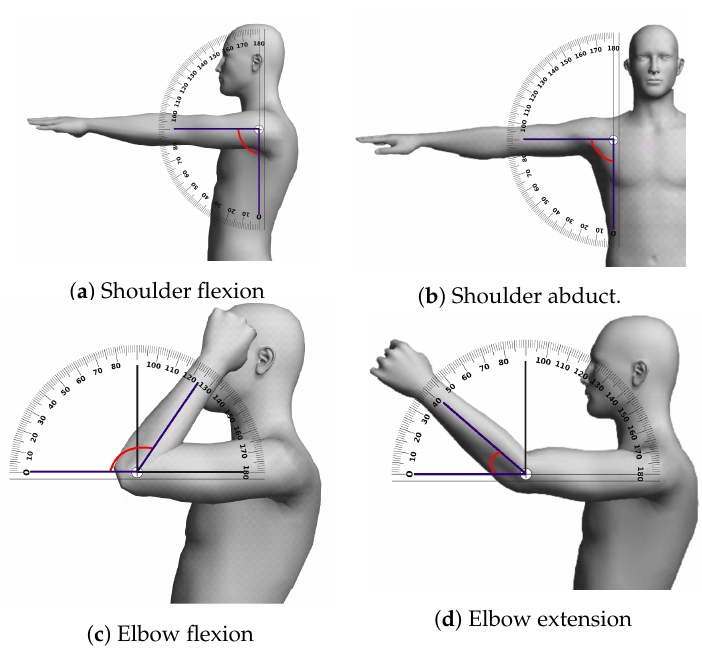
Figure 10. QUEST items automatically evaluated (Pictures generated with Pose Tool